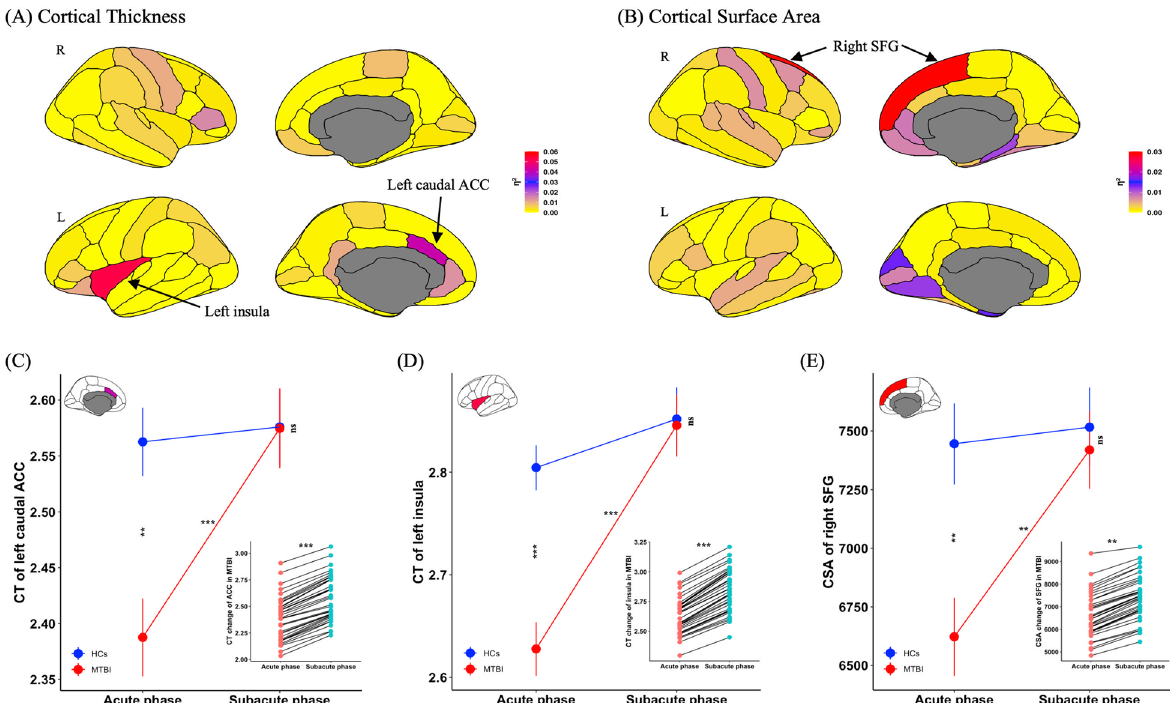
Fig. 3 Neuroanatomic map of effect size of groups-by-timepoints interaction effect in ( A ) CT, and ( B ) CSA of 68 bilateral cortical regions. The CT of left caudal ACC and left insula and the CSA of SFG showed high η 2 for significant interaction effect ( P < 0.05). Cortical regions are color-coded in correspondence to the effect size (η 2 value) of CT or CSA. Red-shaded cortical regions indicate high η 2 for significant interaction effect ( P < 0.05), while yellow-shaded cortical regions indicate low η 2 without significant interaction effect. Simple effect analysis of hub neuroanatomical regions included ( C ) CT of left caudal ACC, ( D ) CT of left insula, and ( E ) CSA of right SFG after significant interaction effect was observed. The subpanels in ( C ), ( D ) and ( E ) show neuroanatomical change for each patient from acute to subacute phase, which indicates significant neuroanatomical restoration in ACC, insula and SFG respectively from acute to subacute phase in patients. MTBI, mild traumatic brain injury; PTH, posttraumatic headache; HCs, healthy controls; CT, cortical thickness; CSA, cortical surface area; ACC, anterior cingulate cortex; SFG, superior frontal gyrus; L, left hemisphere; R, right hemisphere; η 2 , Eta Squared Effect Size. ** , P < 0.01; *** , P < 0.001; ns, not significant. Data are presented as mean